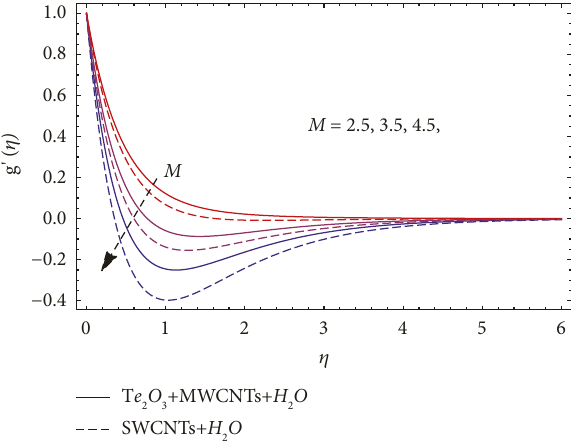
Figure 4: Influence of mixed convection parameter on velocity profile in x direction.